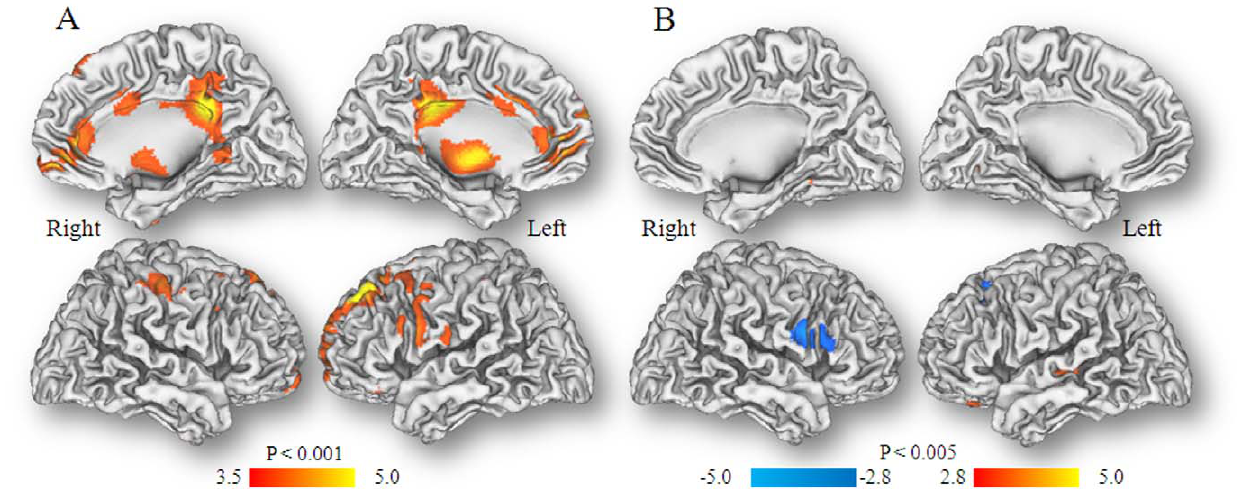
Figure 1. A. SPM results for the ‘‘normalized’’ metabolic images for Neutral vs Cocaine-cues video conditions in the Females. Comparison correspond to Neutral . Cocaine-cues for uncorrected threshold p u , 0.001 cluster . 200 voxels. There were no regions where metabolism was higher during the Cocaine-cues than the Neutral conditions. B. SPM results for the ‘‘normalized’’ metabolic images for Neutral vs Cocaine-cues video conditions in the Males. Comparison correspond to Neutral . Cocaine-cues for uncorrected threshold p u , 0.005 cluster . 200 voxels; we used this lower threshold since there were no significant differences for p u , 0.001. There were no regions where metabolism was higher during the Cocaine-cues than the Neutral